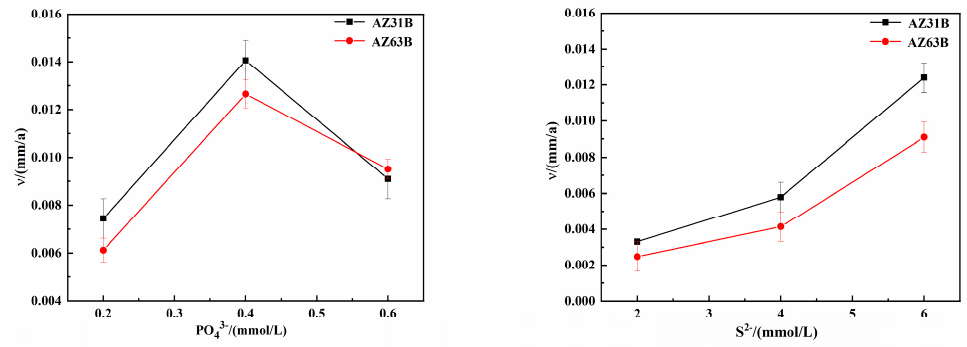
Figure 6. Corrosion rates of the magnesium alloy calculated from weight-loss measurements after 6 6 days of testing under varied days of testing under varied concentrations.